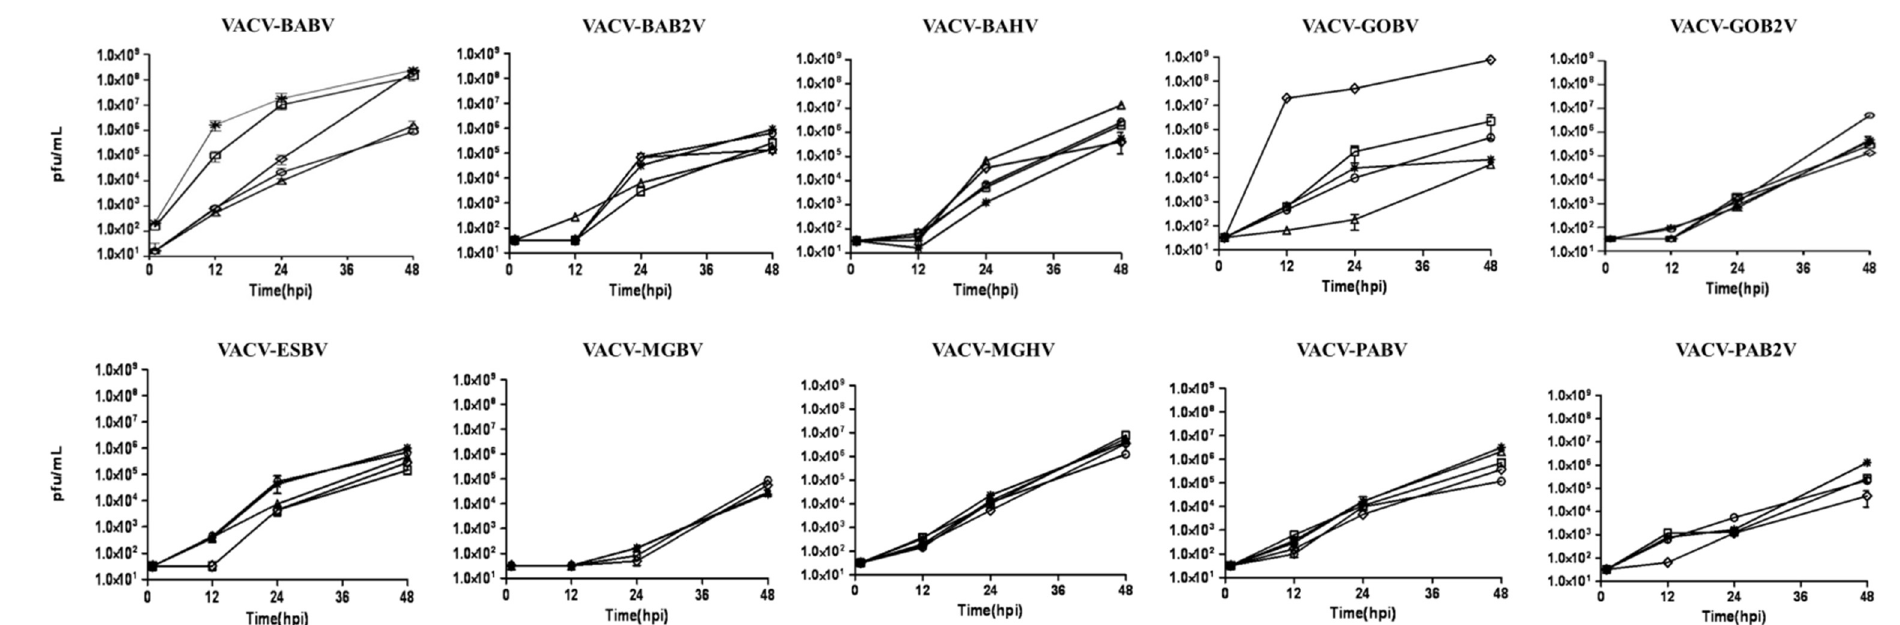
Figure 3. Growth curves assay of VACV-BR clones in BSC-40 cells. Cells were infected at an MOI of 0.01. Viral replication was determined by measuring the viral titer at 0, 12, 24 and 48 h after viral adsorption. The legend is the same for all the graphics: clone 1 (O), clone 2 ( ◊ ), clone 3 (*), clone 4 ( □ ), and clone 5 ( ∆ ) when present. Each data point represents the average of two independent experiments. The analysis was performed using GraphPad Prism 6.0 software (Version 5.00, GraphPad Software, San Diego, CA, USA,